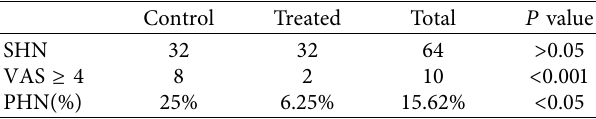
Table 6: The two groups of postherpetic neuralgia incidence rate. Control